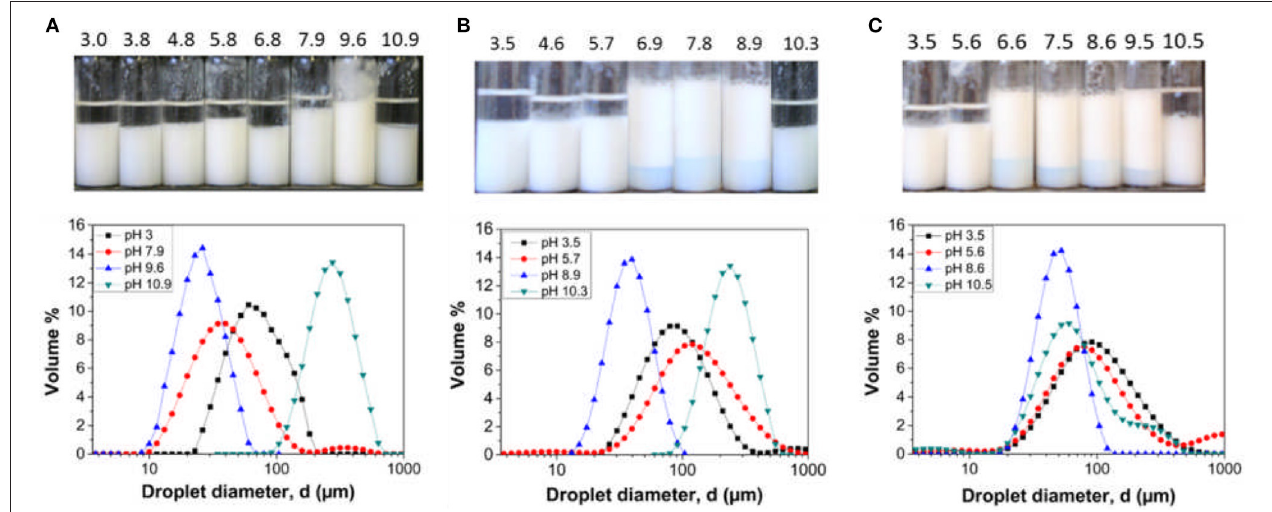
FIGURE 4 | Hexadecane in water emulsions stabilized by (A) LP-DMAEMA 54 , (B) LP-DMAEMA 108 and (C) LP-DMAEMA 245 as a function of pH. Digital micrographs of the emulsions 24h after production (top) and the droplet diameter distribution based on volume % (bottom). No background electrolyte was added to the continuous phase and measurements were performed a 25 ◦